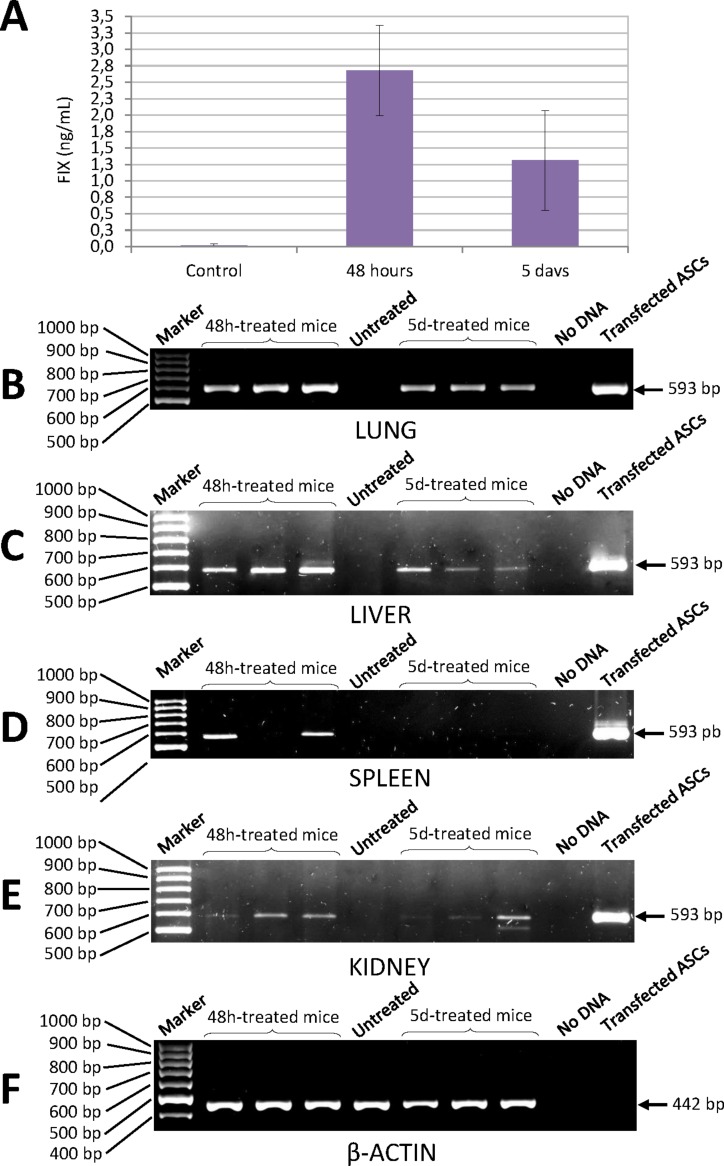
Human FIX expression in mice treated with nucleofected ASCs.(A) Levels of human FIX determined by ELISA in plasma of either control or cell-treated mice at different time points. Untreated control group was made up of 3 animals (0.02 ± 0.01 ng/mL). Concentration of human FIX was 2.68 ± 0.69 ng/mL 48 h after injection (n = 6) and 1.31 ± 0.76 ng/mL at 5 days (n = 6). (B) Human FIX expression was detected by RT-PCR in lung, (C) liver, (D) spleen and (E) kidney of NSG mice. (F) Representative image of mouse β-actin expression in lungs. β-Actin-control was performed in all tissues where Factor IX was also analysed. Lane 1: 100 bp DNA marker. Lanes 2–4: DNA from tissues of treated mice 48 h after cell injection. Lane 5: DNA from tissue of a control mouse without cell treatment. Lanes 6–8: DNA from tissues of cell-treated mice 5 days after injection. Lane 9: negative control (no DNA). Lane 10: DNA from ASCs transfected with pIRES2-EGFP-FIX plasmid.